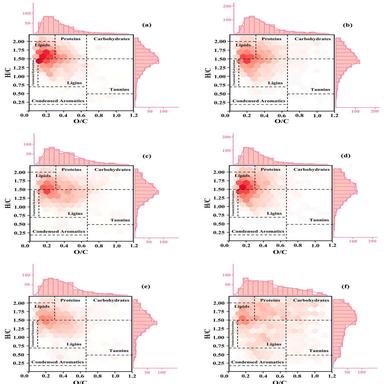
Van Krevelen density diagram of DOM in the drinking water treatments. (a) RW; (b) PRE; (c) SED; (d) OZ; (e) BAC; (f) TW.